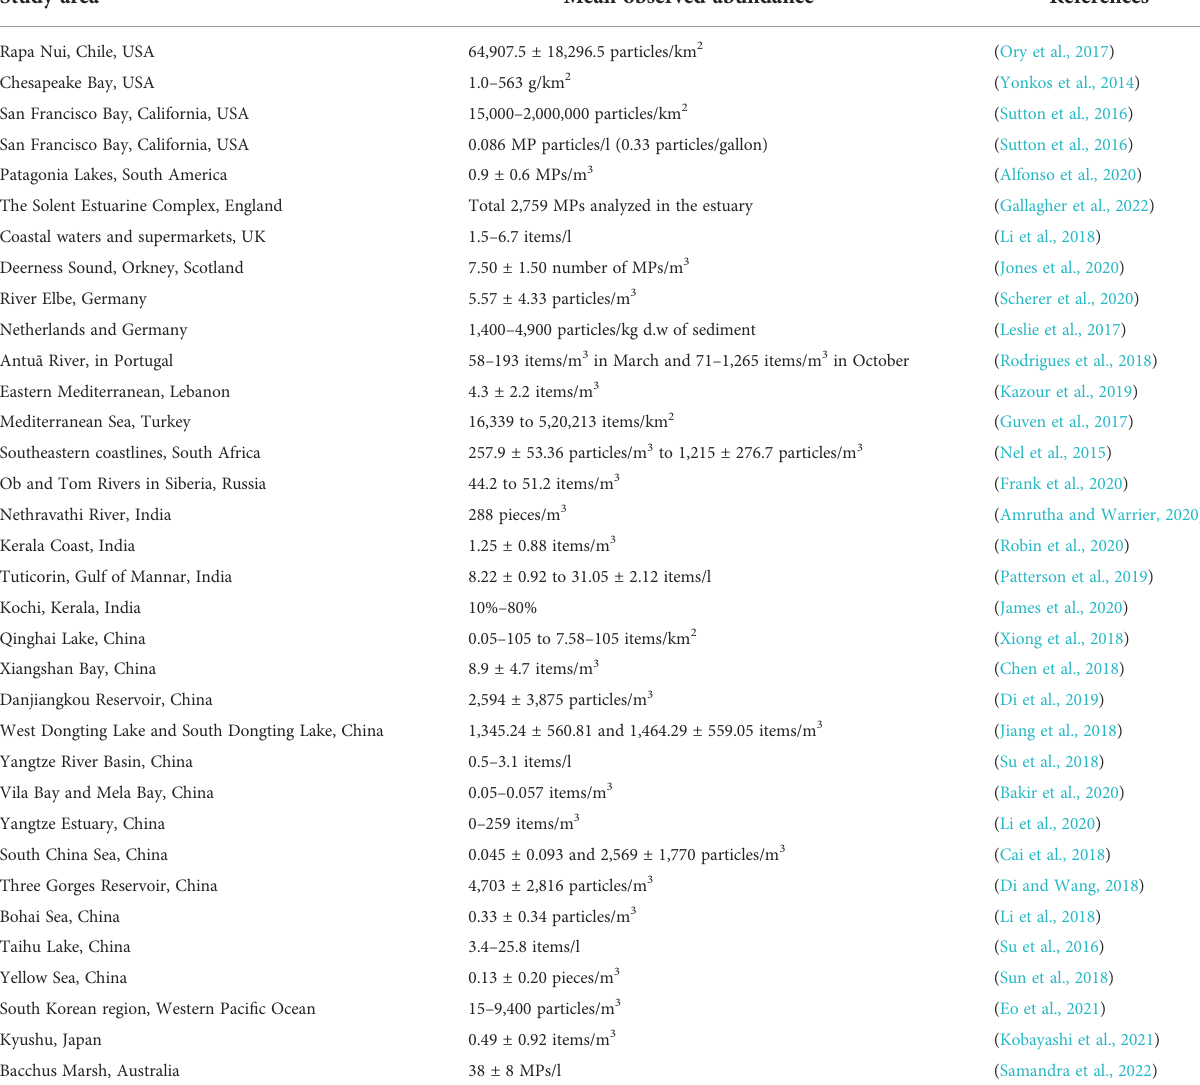
TABLE 2 Studies on MP abundance in water summarized from reports across the